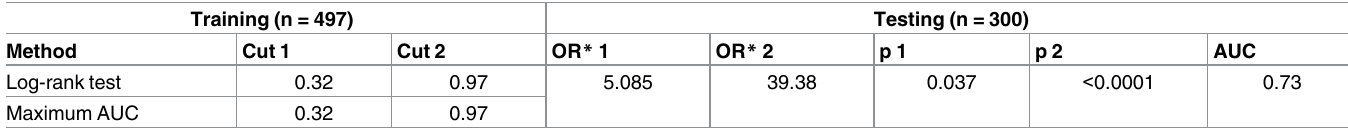
Table 5. Multiple cutoff points: Depth of stromal invasion (in fraction) against risk of lymphovascular space invasion